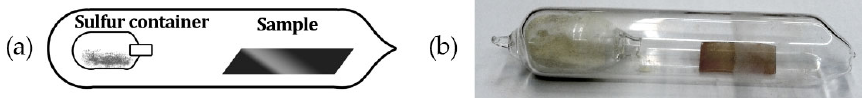
Figure 1. ( a ) Schematic; ( b ) real representation of quartz ‐ sealed tubes for sulfurization process. Table 1. Sample coding system.